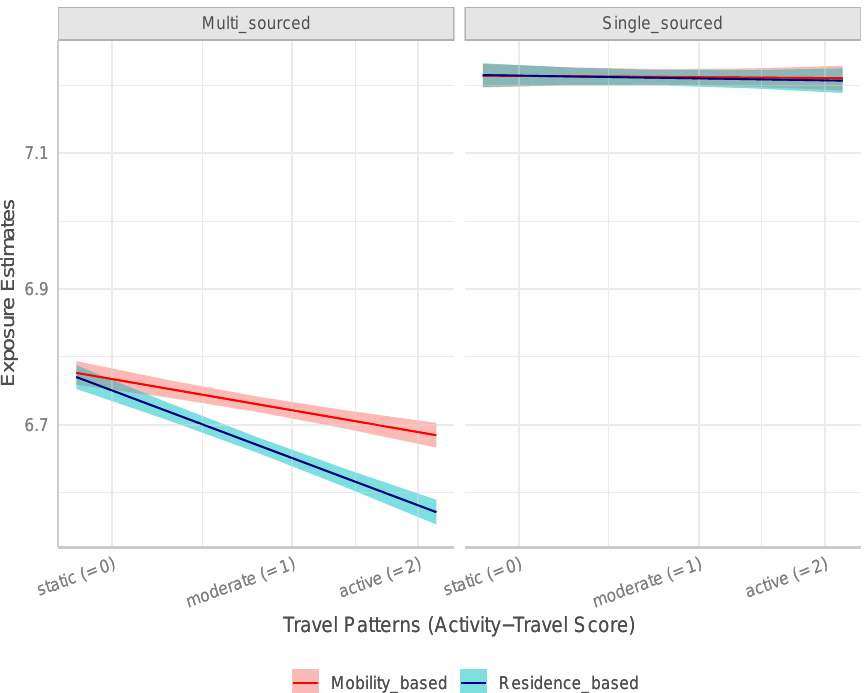
Figure 4. The three-way interaction effects of individuals’ daily mobility, routine travel patterns, and the exposure models on long-term exposure to ambient PM 2.5